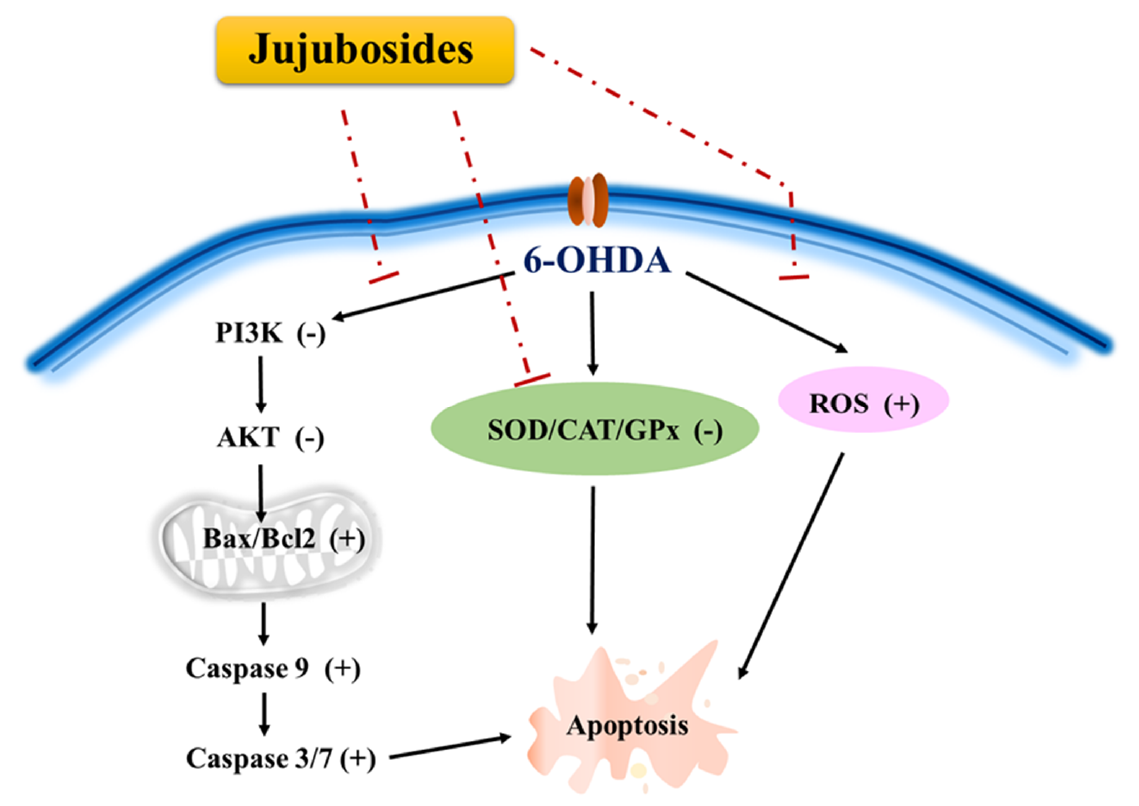
Figure 13. The overall network of how the 6-OHDA induced neurotoxicity and how jujubosides conducted their rescuing